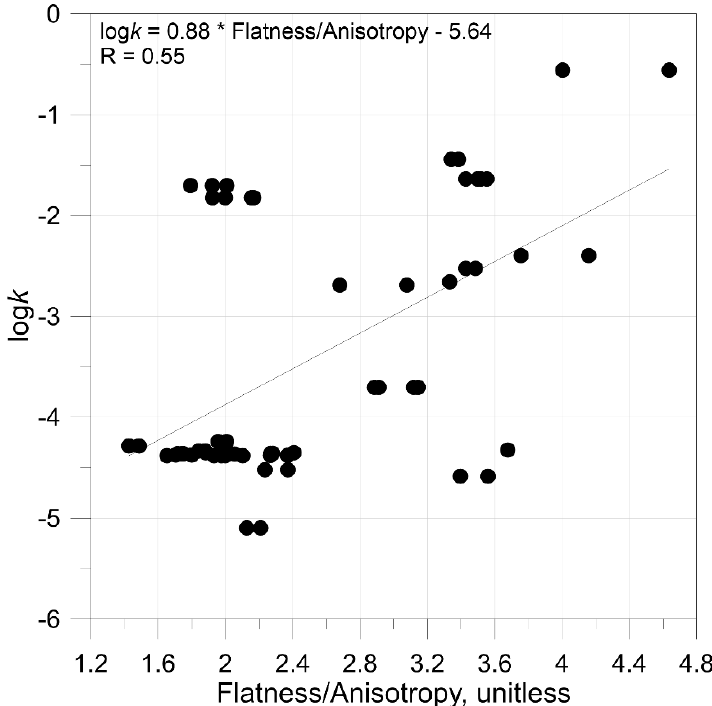
Figure 13. Relationship between the logarithm of absolute permeability and the ratio of Flatness and Anisotropy based on percentile 90 data set for all samples.